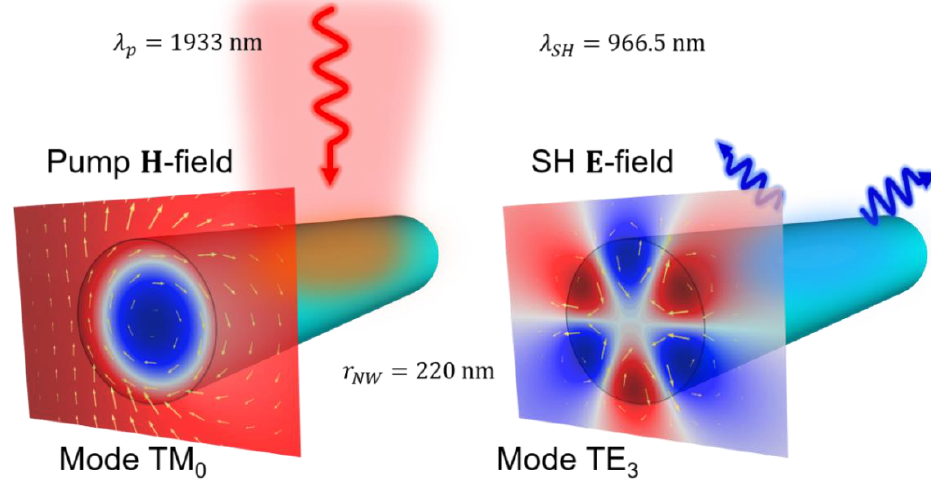
Figure 5. Pump and SH field distribution for a GaAs nanowire with radius 220 nm illuminated with TM-polarized pump source tuned at 1933 TM-polarized pump source tuned at 1933 nm.